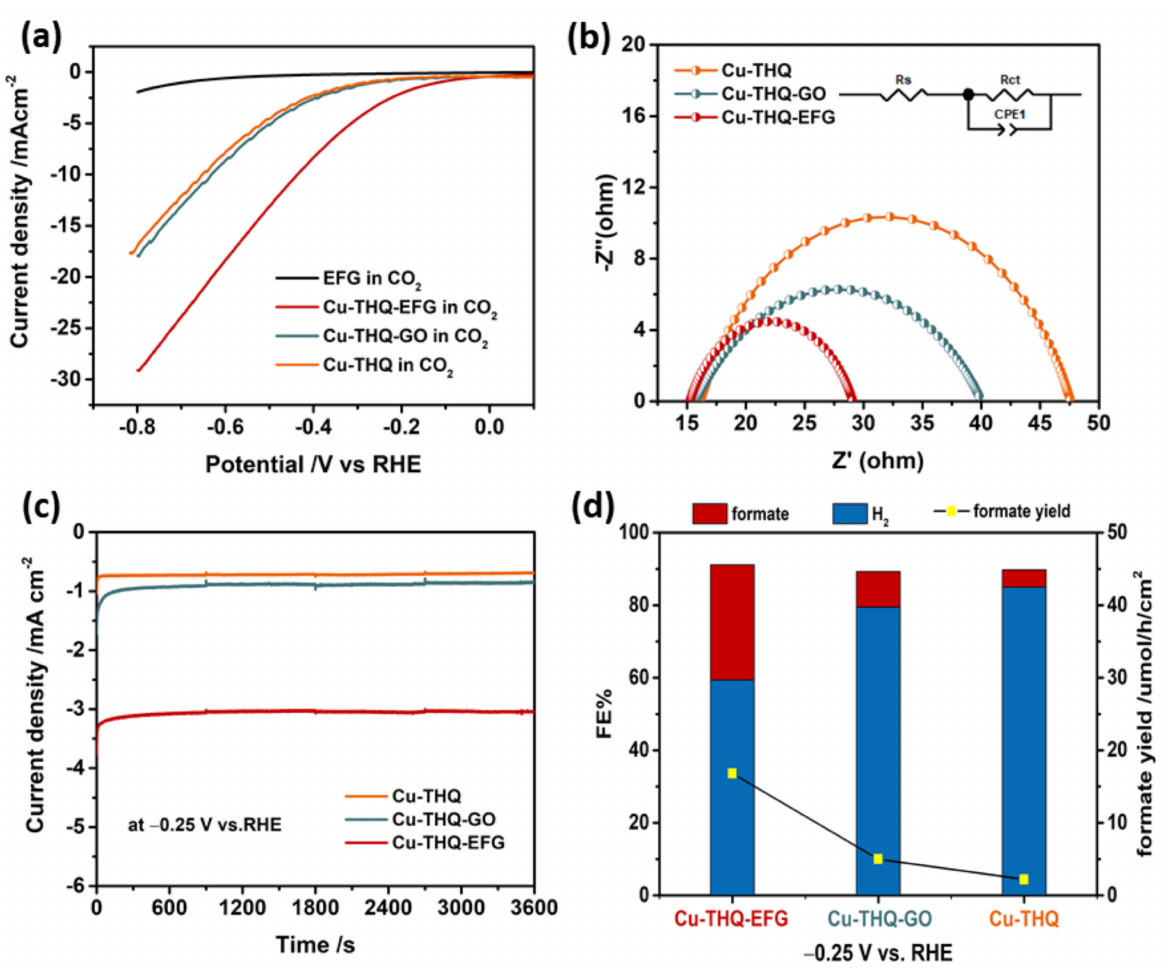
Figure 3. ( a ) LSV curves in 0.1 M NaHCO 3 electrolyte, ( b ) EIS data of the Cu-THQ MOF, Cu-THQ-GO and Cu-THQ-EFG, respectively; ( c ) current density, ( d ) faradaic efficiency of H 2 and formate yield for Cu-THQ, Cu-THQ-GO and Cu-THQ-EFG at the fixed potential − 0.25 V vs. RHE. Cu-THQ-EFG exhibits an excellent electrochemical stability as shown on Figure